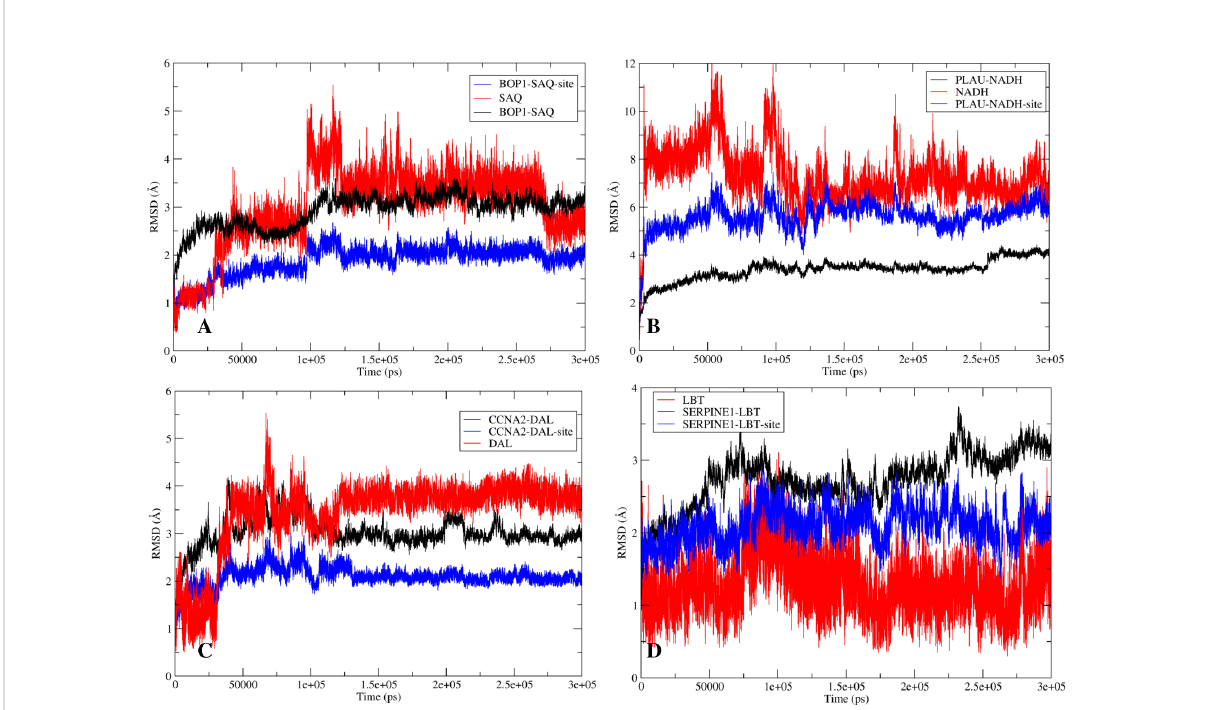
FIGURE 8 The stability analysis: The root mean square deviation (RMSD) analysis for the protein-ligand complexes. The RMSD of protein is shown in red while the RMSD of ligand is shown in blue. (A) RMSD for BOP1-Saquinavir complex. (B) RMSD for PLAU-NADH complex. (C) RMSD for CCNA2-Diacetolol complex. (D) RMSD for SERPINE1-Labetalol